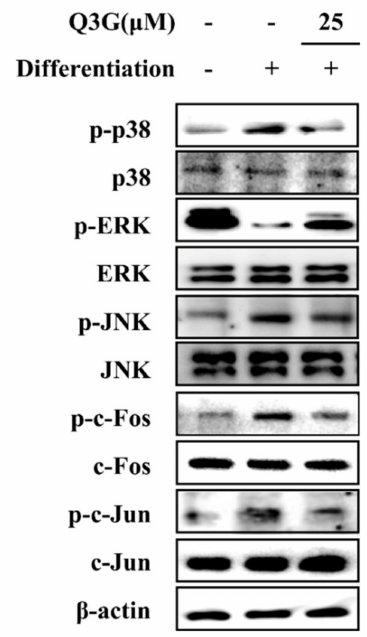
Figure 7. E ff ect of Q3G on the MAPK / AP-1 signaling. Analysis of MAPK and AP-1 activation and was carried out with Western blotting of whole cell lysates of adipo-induced hBM-MSCs at day 10 of di ff erentiation. Q3G was treated with initial di ff erentiation for 3 days. β -actin was used as internal loading